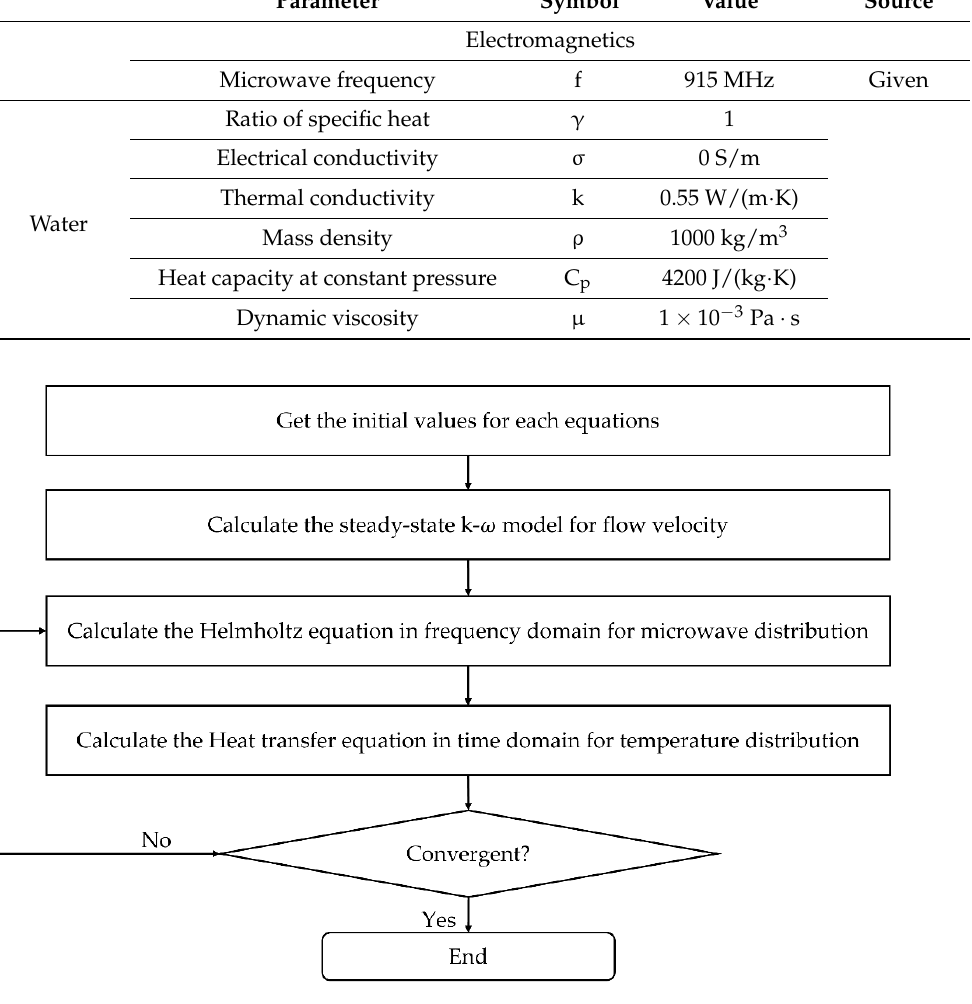
Figure 2. Calculation